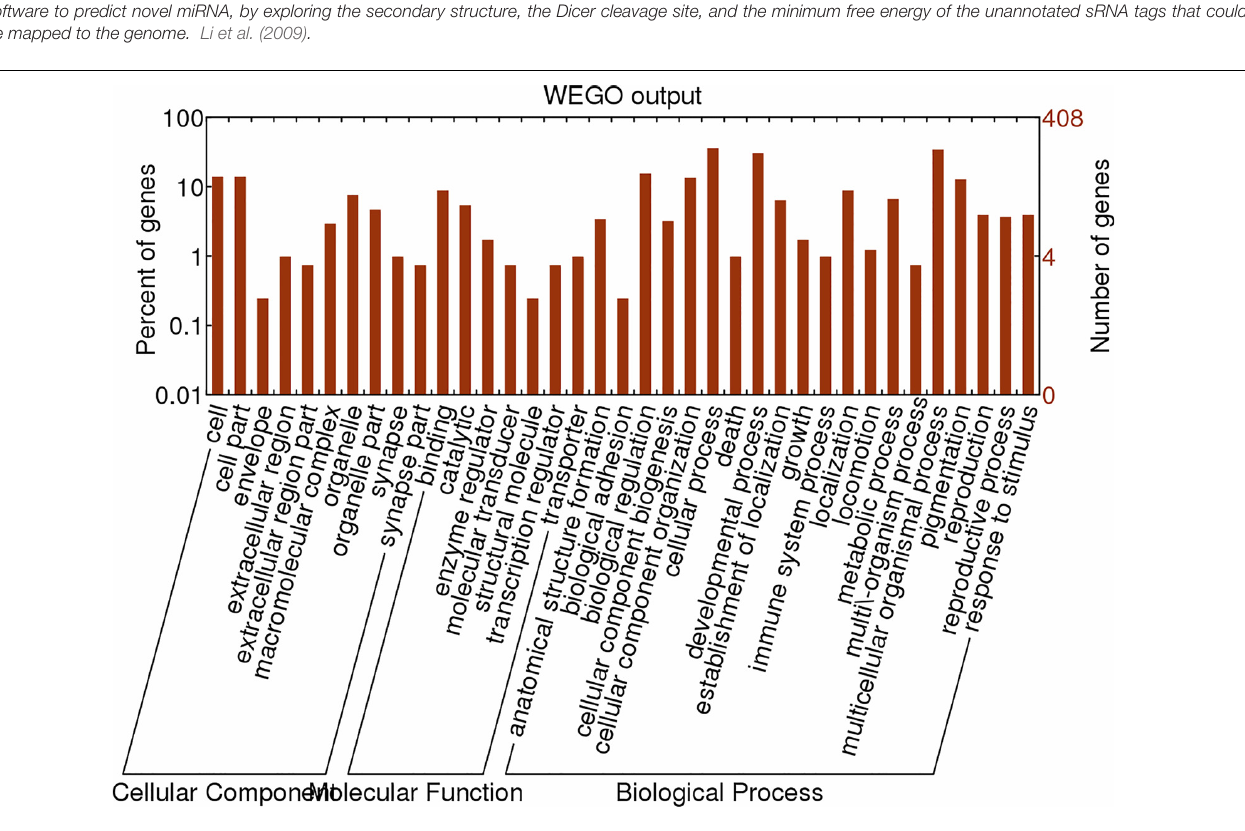
FIGURE 4 | Partial GO classification annotated by Gene2GO for predicted target genes. The figure shows partial GO enrichment for the predicted target genes in terms of cellular components, molecular functions, and biological